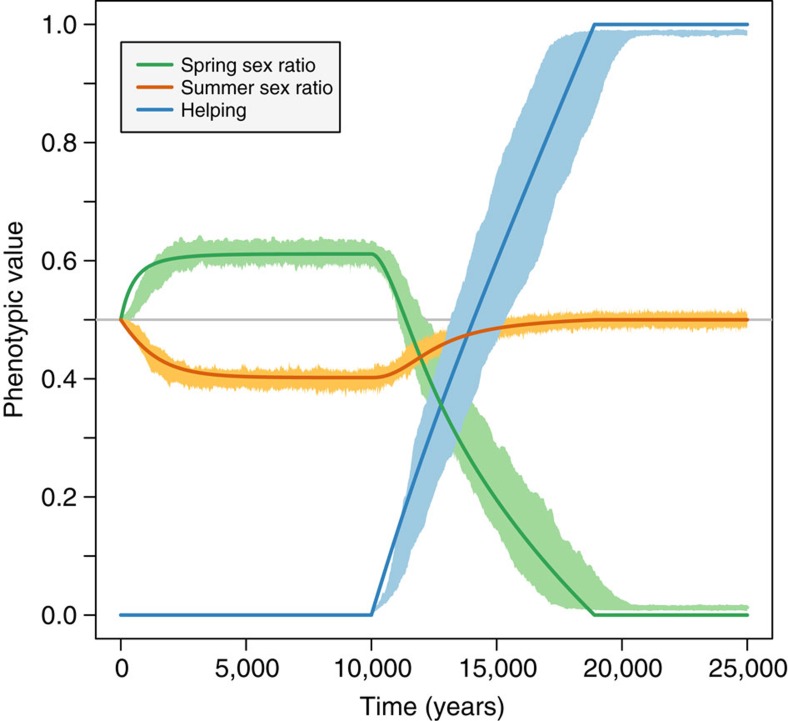
Coevolutionary dynamics driving the evolutionary transition.Helping behaviour (blue), spring (green) and summer (yellow) sex ratios coevolved in populations with a female hibernation life cycle, haplodiploid genetics and lifetime monogamy. Smooth darker curves are deterministic predictions from the mathematical inclusive fitness model; more lightly coloured ribbons represent corresponding outcome ranges of 10 stochastic individual-based simulations. During the first 10,000 generations, helping is not allowed to evolve, while sex ratios evolve towards male-biased spring broods and female-biased summer broods. From generation 10,000 onwards, helping is allowed to evolve: initial evolution of helping behaviour feeds back on sex ratio selection, reversing the direction of selection on sex ratios; as helping evolves towards maximal levels (h→1), implying that all first brood offspring have become workers, spring broods evolve towards 100% female sex ratios (z1→0), while summer broods evolve towards an even sex ratio (z2→1/2). At evolutionary equilibrium, a transition has occurred from a partially bivoltine life cycle without helping behaviour towards a social univoltine life cycle with the production of a first brood of unmated workers followed by a second brood of reproductives with an even sex ratio. Parameter values Sf=0.9, Sm=0.6, b=1.5, F1=F3=5.0.